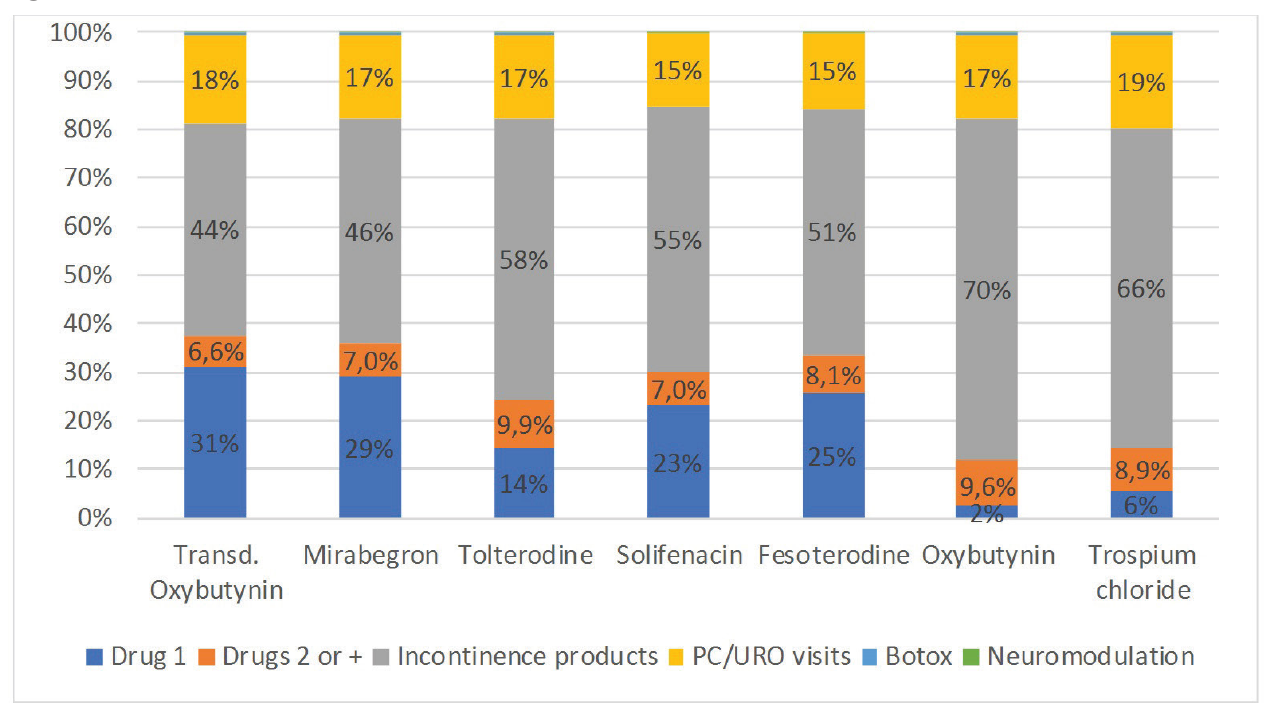
Figure 3. Distribution of Total Cost after 5